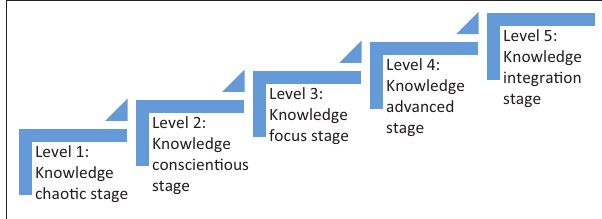
FIGURE 1: Knowledge management maturity